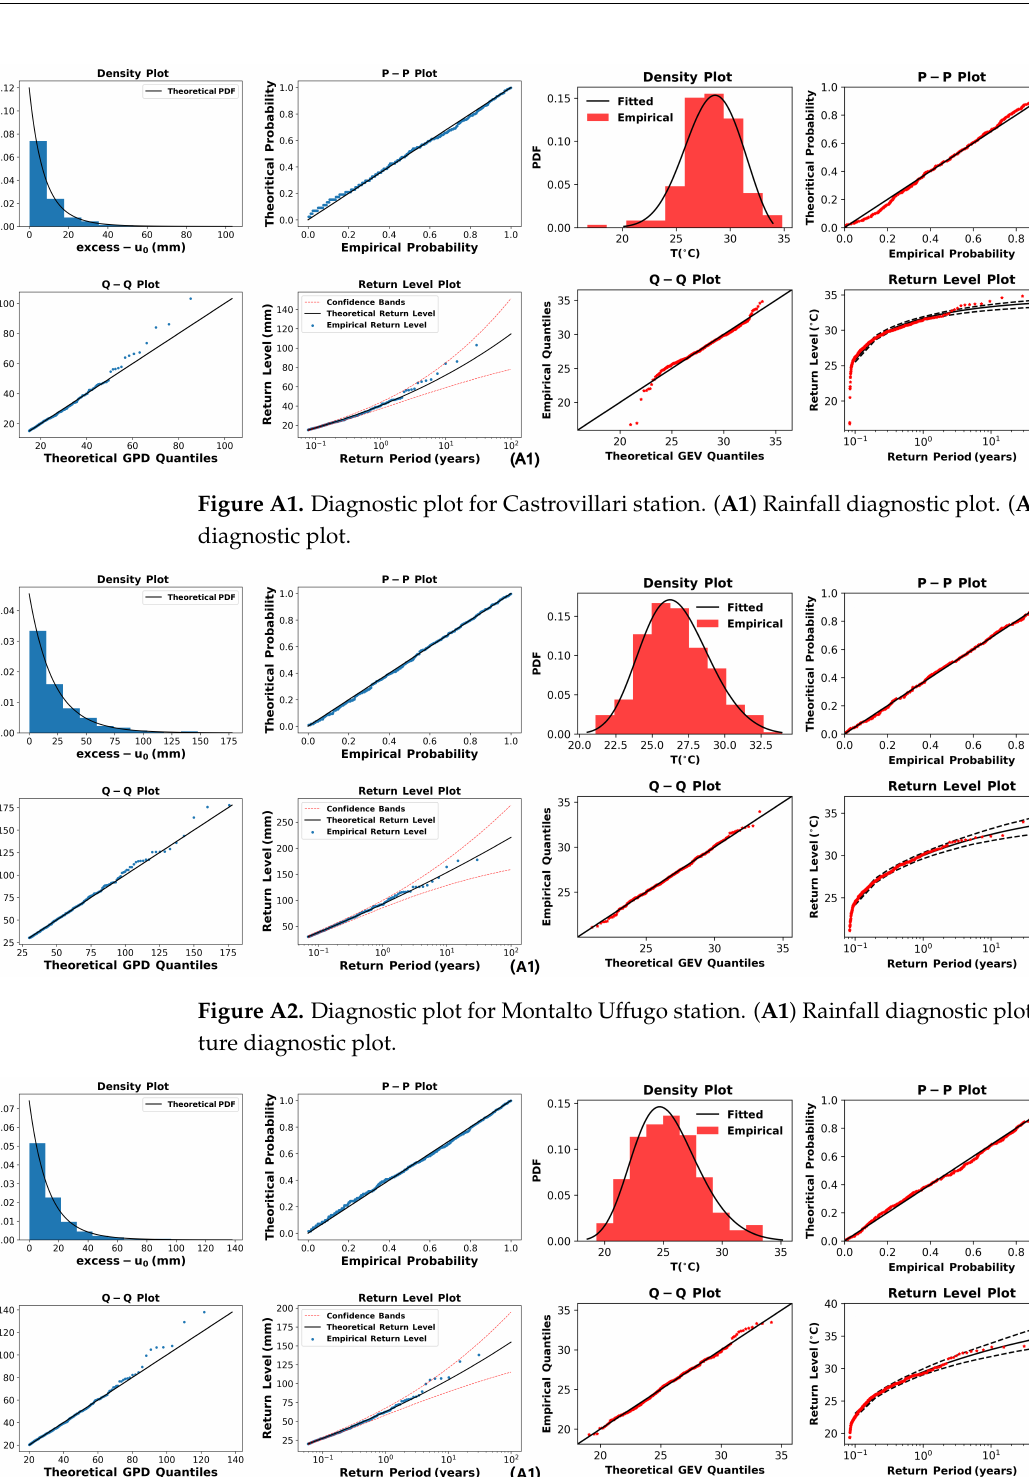
Figure A3. Diagnostic plot for Nicastro station. ( A1 ) Rainfall diagnostic plot. ( A2 ) temperature diagnostic